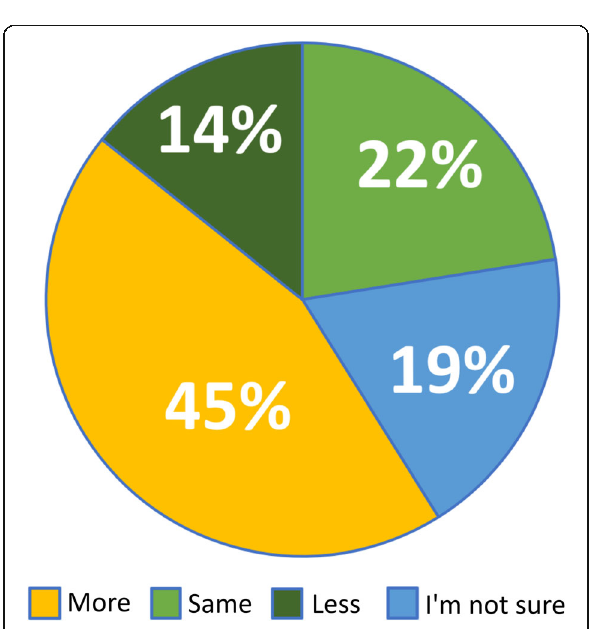
Fig. 11 Teacher use of video during pandemic compared to other